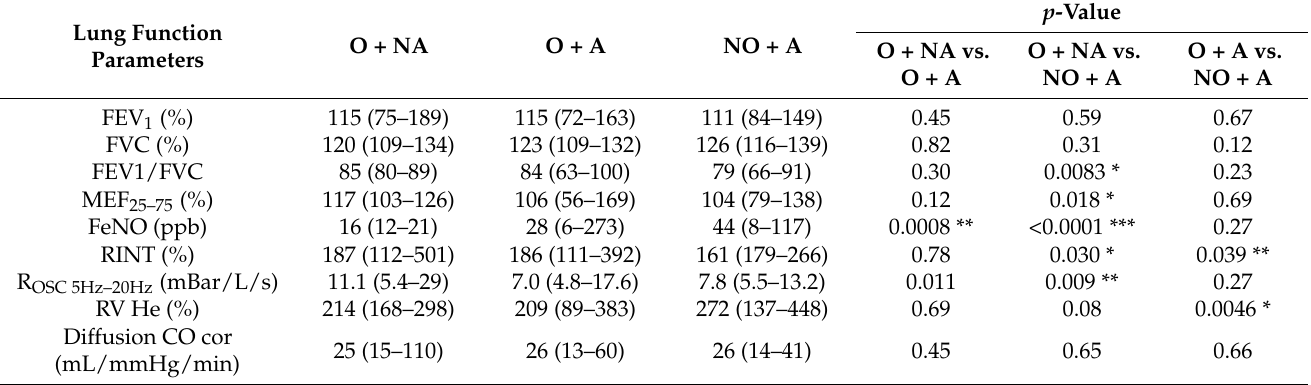
Table 2. Lung function testing in the study population. Values are expressed as median and minimum- maximum. FEV 1 : forced expiratory volume in 1 s; FVC: forced vital capacity; MEF 25–75 : mean flow between 25% and 75% of FVC; FeNO: fractional exhaled nitric oxide; RINT: resistance by interrupter technique; R OSC 5Hz–20Hz : difference in impulse oscillometry between airways resistance at 5 Hz and 20 Hz; RV: residual volume; CO: carbon monoxide. * = p < 0.05, ** p < 0.005, *** = p <